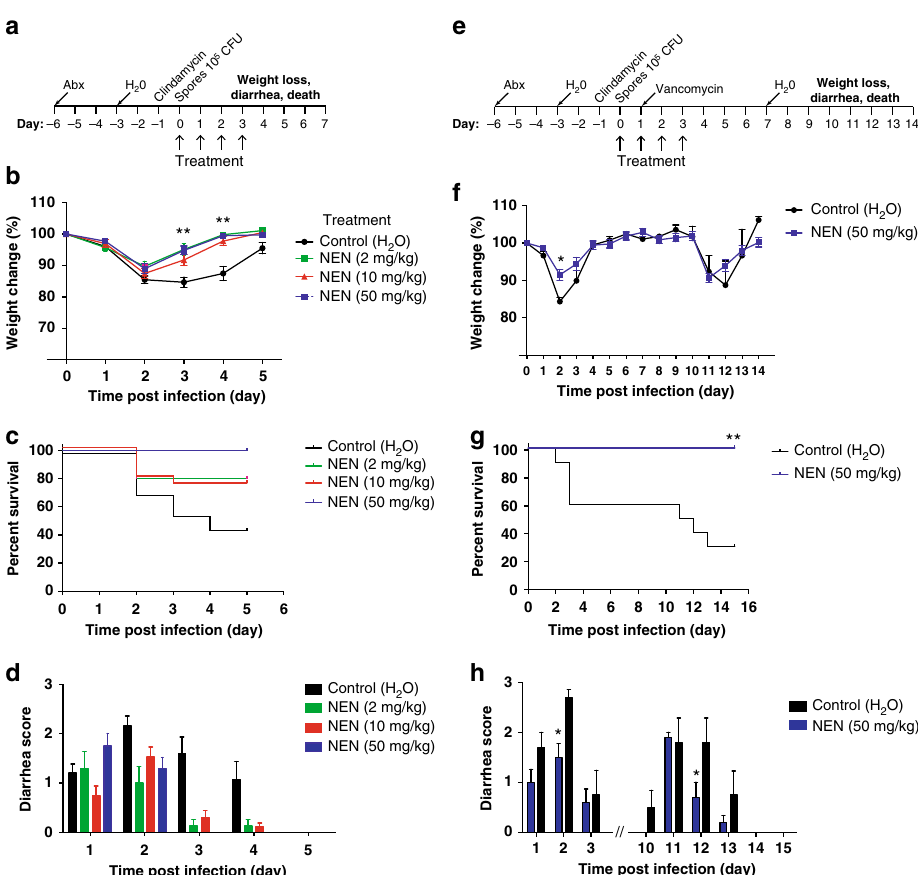
Fig. 3 Niclosamide ethanolamine (NEN) is protective in primary and recurrent CDI. a Protocol schematic for primary CDI model. b Weights of mice after challenge with C. dif fi cile spores (10 5 CFU/mL) on day 0. Mice were treated with vehicle (5% DMSO) or NEN (in 5% DMSO) at different doses (2, 10, and 50 mg per kg). Each point is the mean SE from day 0. c Mouse survival as determined by a log-rank/Mantel – Cox test. d Diarrhea score of infected mice 5 . e Protocol schematic for recurrent CDI model. f Weights of mice after C. dif fi cile spore challenge (day 0) followed with vancomycin in their drinking water for recurrence CDI model. g Survival of infected mice treated and un-treated with NEN (50 mg per kg). h Diarrhea score of infected mice. * p < 0.05; ** p < 0.01 using unpaired Student t -test. Data represent 10 mice/group Table 2 MIC values for niclosamide, NEN, and vancomycin on Clostridial species Organism